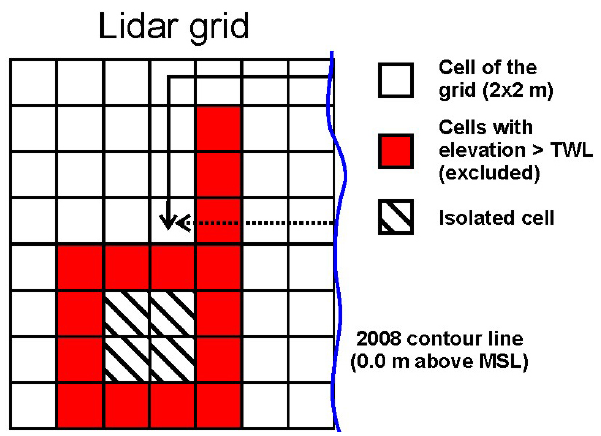
Figure 3. Schematic example of the method applied to produce hazard maps: red squares are excluded areas (elevation>TWL of each scenario, step 1); the squares with oblique black lines iden- tify an isolated area (there are no paths that connect the shoreline to that area, i.e. the area is safe from inundation, step 2). Differ- ence between the least path method and the Euclidean distance: the black arrow indicates the least path that connects the shoreline to the cell, calculated with the Cost–Distance tool (cumulative dis- tance = 7 cells, i.e. 14m because one cell is 2 × 2m); the dashed arrow indicates the Euclidean